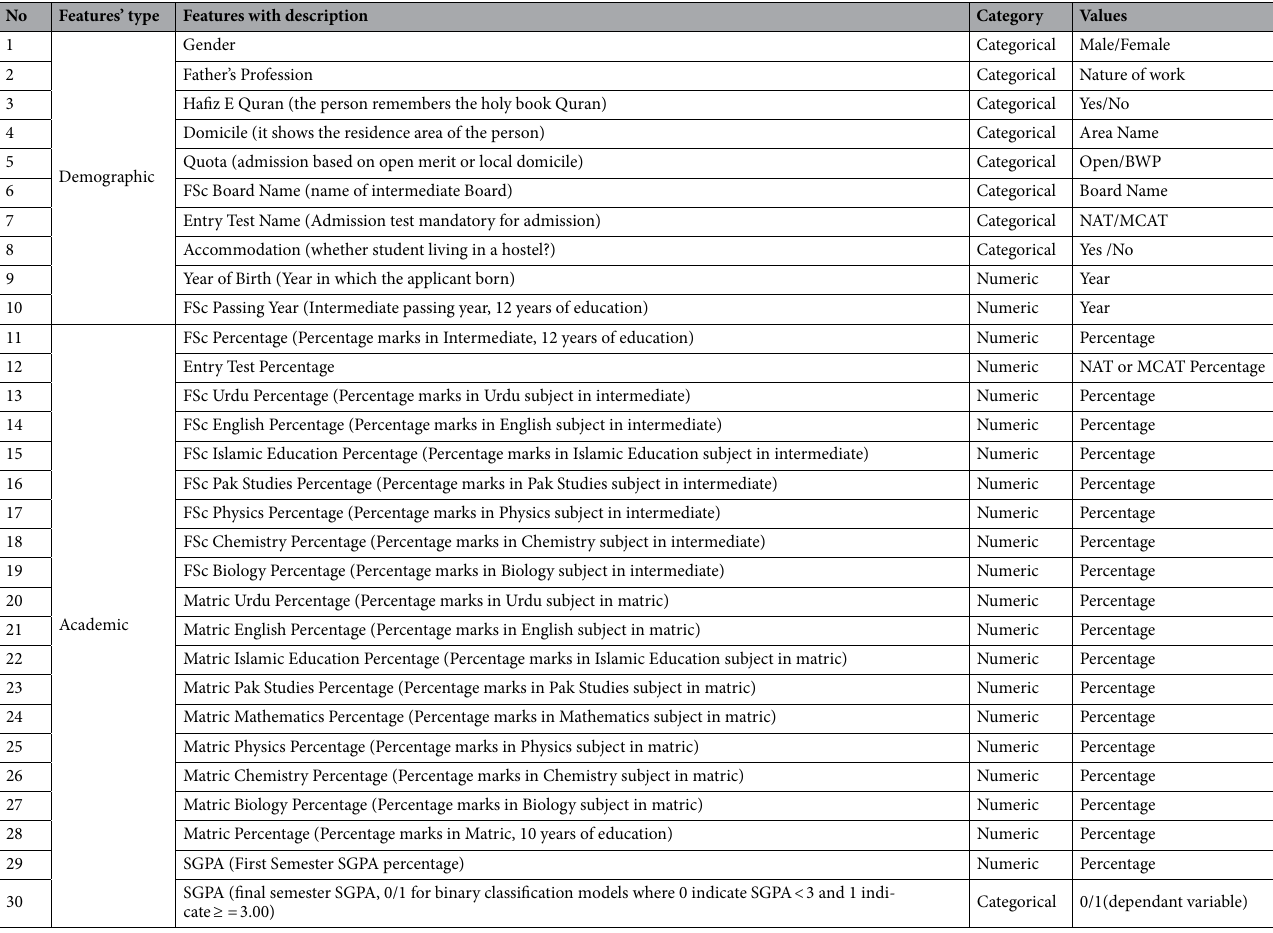
Table 1. Dataset variables and their